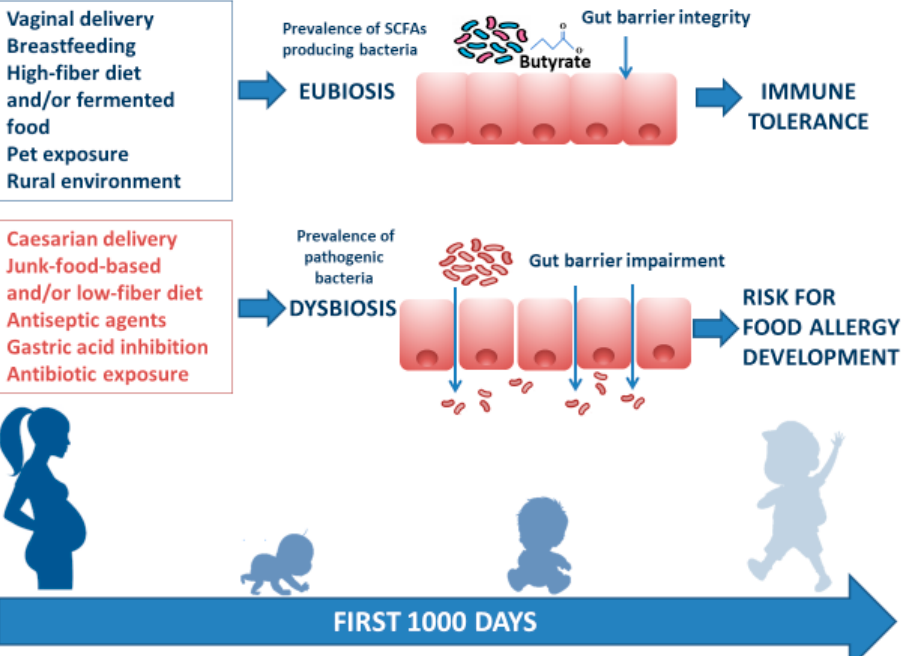
Figure 2. Infant gut microbiome composition and function is related to multiple environmental factors. The “first 1000 days” start from intrauterine development to the first 2 years of life and represent the frame of gut microbiome structure and function shaping. The ideal path begins with a full-term gestational period, followed by spontaneous delivery, breastfeeding provided by a mother following a Mediterranean diet lifestyle, earlier rural environmental exposure, and infant intake of a high-fiber diet and/or fermented food. All these factors are responsible for gut eubiosis, with a prevalence of SCFA-producing bacteria and gut barrier integrity, laying foundations for a healthy status and for a long-lasting protection against noncommunicable chronic diseases (such as FA) later in life. Conversely, caesarian delivery, from a mother following a junk-food-based and/or low-fiber diet, and direct or indirect childhood exposure to antiseptic agents and drugs (mainly antibiotics and gastric acidity inhibitors) leads to gut dysbiosis with prevalence of pathogenic bacteria, reduction of immunomodulatory factor production, increased gut barrier permeability, and a risk for FA development.